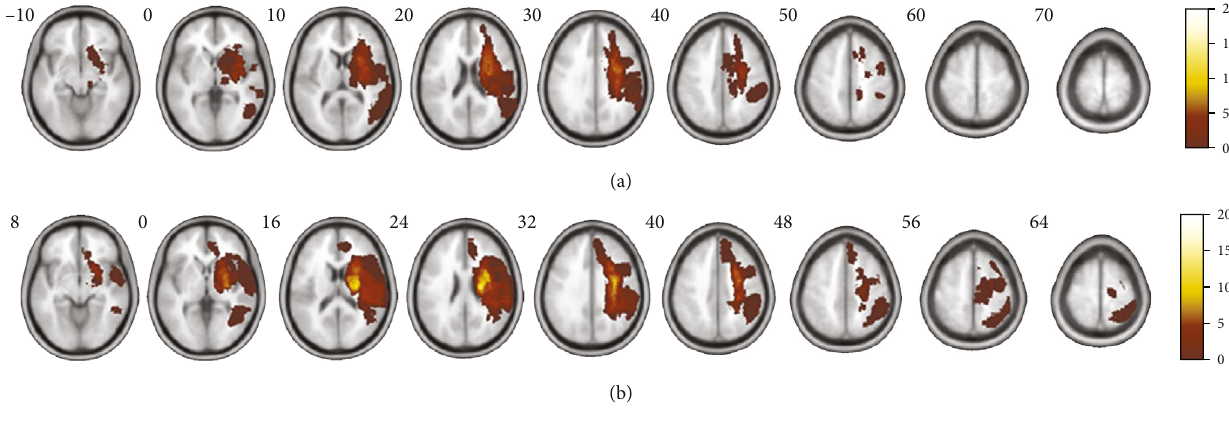
Figure 2: Individual lesion masks were drawn and then spatially normalized to the Montreal Neurological Institute (MNI) space. The decision to fl ip all left lesions to the right was arbitrary. The lesion masks of (a) valine (Val) homozygotes of the BDNF genotype and (b) methionine (Met) allele carriers of the BDNF genotype superimposed onto MNI space. Colored bars represent levels of overlap in each lesion. Red indicates infrequent overlap, while white indicates frequent